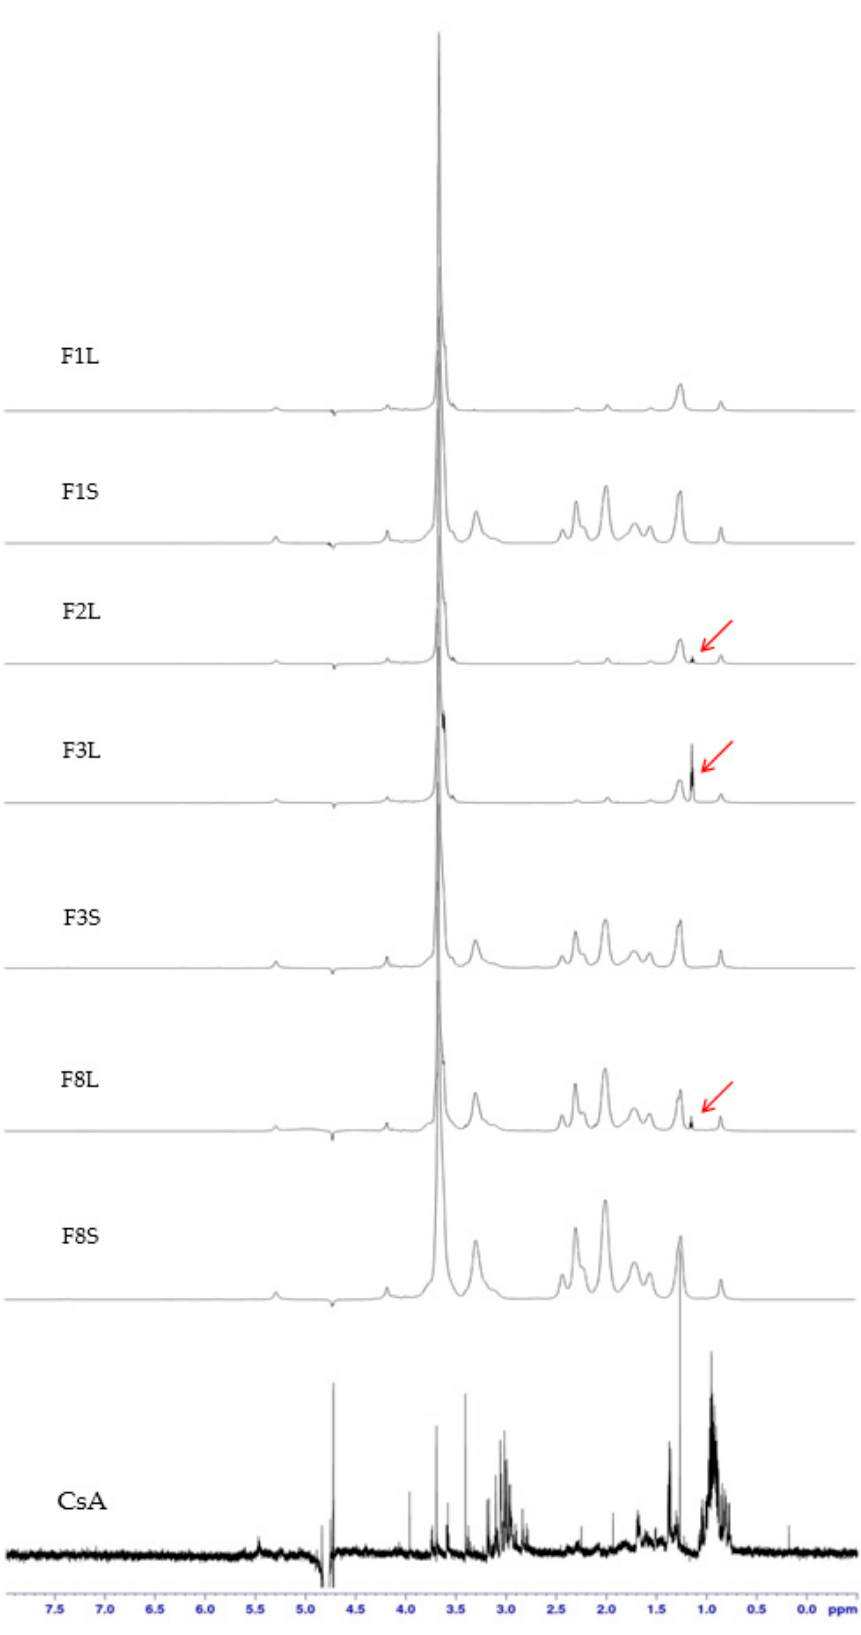
Figure 8. High-resolution proton nuclear magnetic resonance ( 1 H NMR) spectra of the SLM placebo and with CsA prepared “de novo” (FL) and after spray drying (FS) with Compritol (F1–F3) or stearic acid (F8).